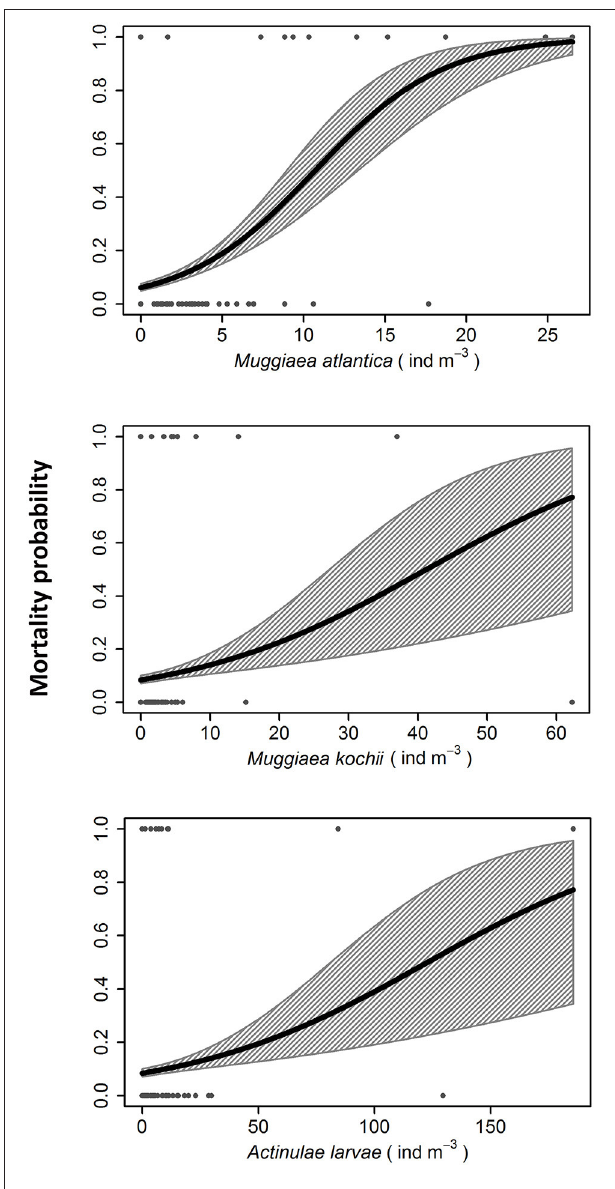
FIGURE 4 | Probability of fish mortality event at different densities of identified harmful cnidarian species ( Muggiaea atlantica , Muggiaea kochii, and Ectopleura larynx actinula larvae). The dots at the top and bottom axes represent the mortality presence/absence over the